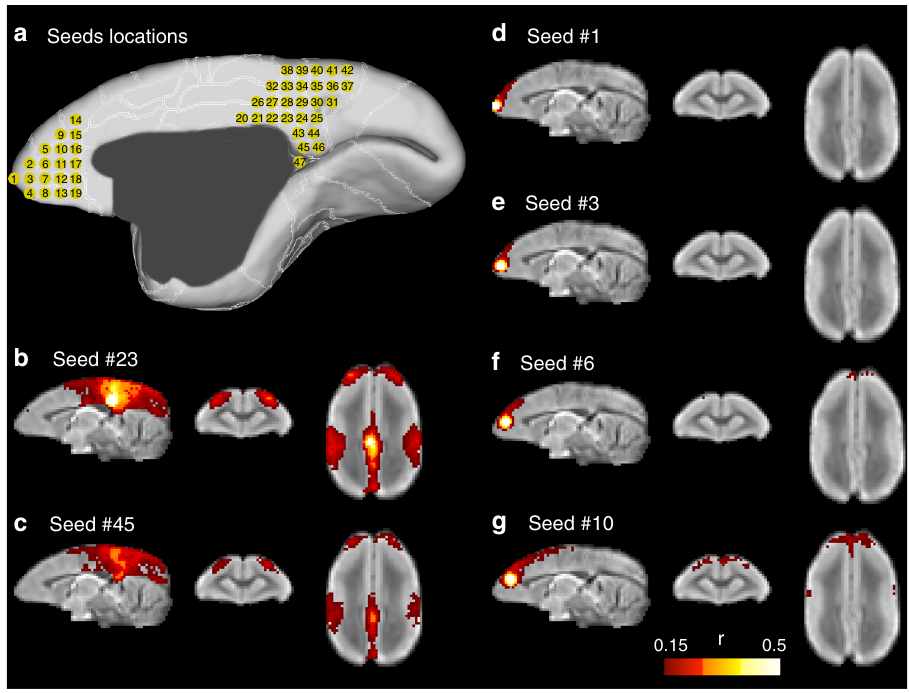
Fig. 5 Exploratory seed-based analysis. a Nineteen seeds were placed across the mPFC and 28 seeds across the medial parietal, posterior cingulate, and retrosplenial cortices. b – g Correlation maps of a few selected seeds. Correlation maps of all seeds are listed in Supplementary Fig. 4. For visualization purpose, we set an arbitrary threshold ( r > 0.15) to remove low correlations. The threshold was selected based on the correlation in the previous ICA, in which the lowest correlation between the medial frontal region and the posterior regions was r = 0.18. Correlation maps with a lower threshold ( r > 0.1) are also provided in Supplementary Fig.